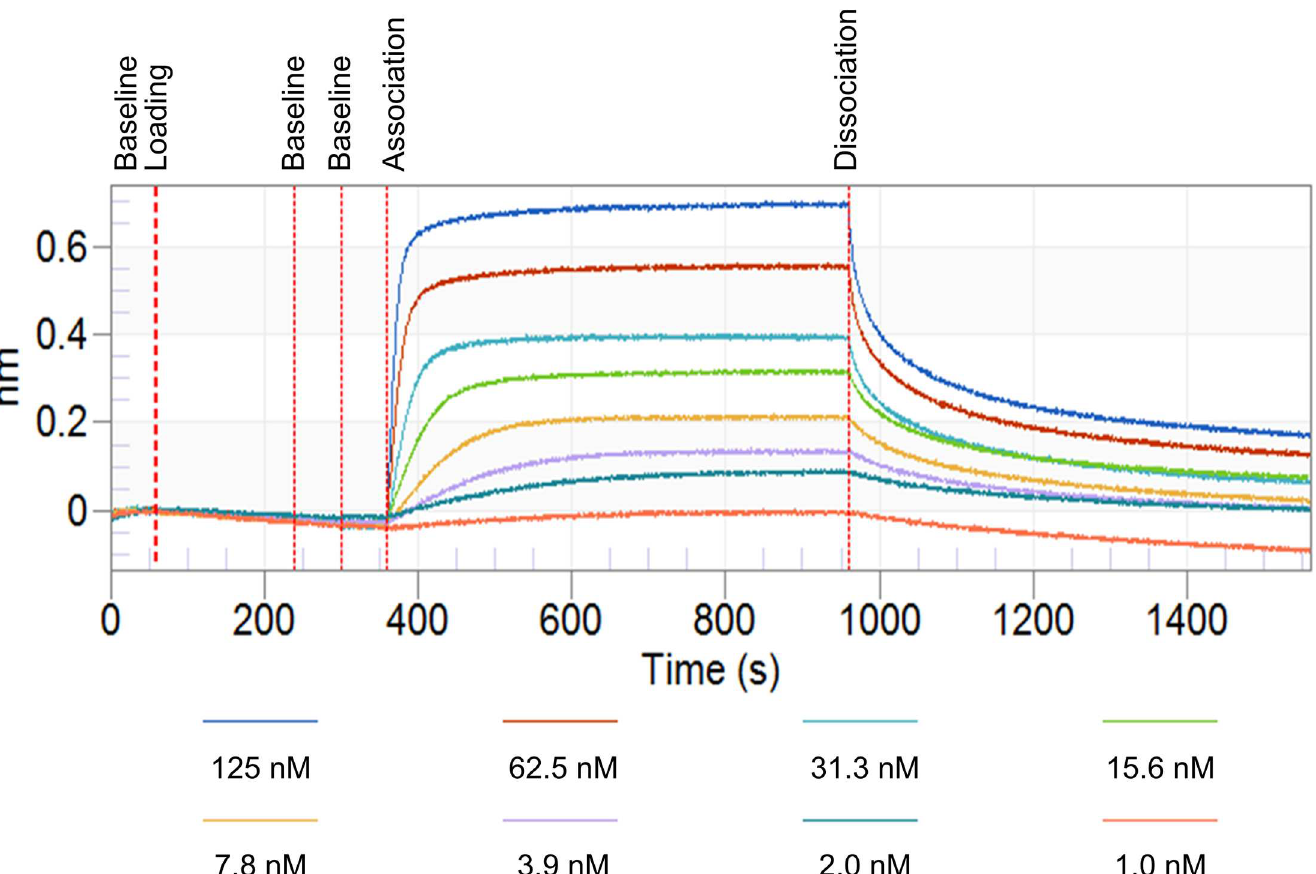
Fig 5. Representative HCI.SDF1 and MAB350 binding kinetics data. Representative data obtainedfrom label-freesensor evaluation of HCI.SDF1 and MAB350 with Amine Reactive Second-Generation (AR2G) Biosensors.